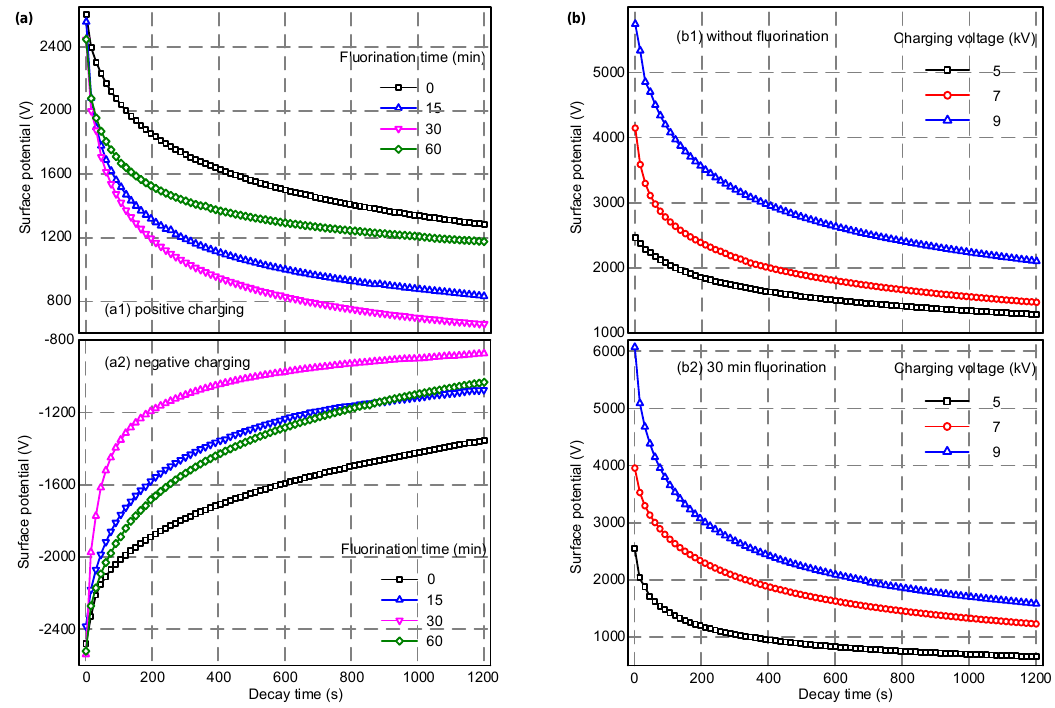
Figure 5. The surface potential decay process of samples with various fluorination time under different charging voltage levels. ( a ) Effects of fluorination time; ( b ) effects of charging voltage.